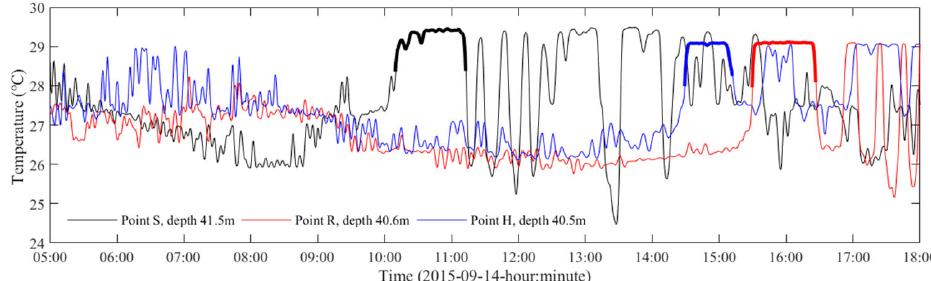
Figure 2. Temperature versus time measured at points S (black), R (red), and H